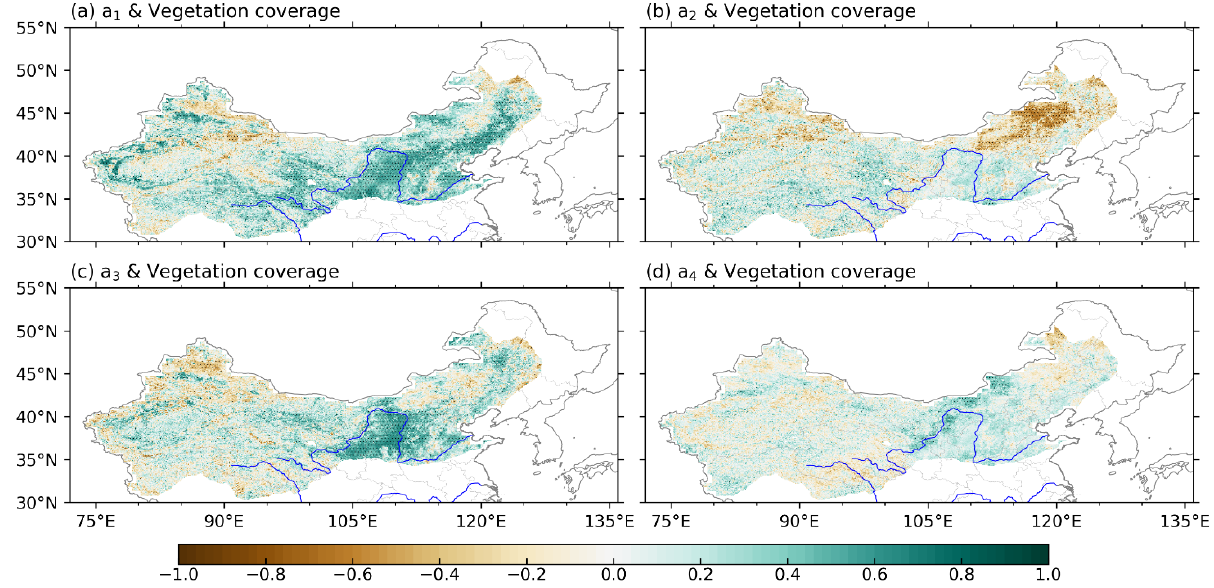
Figure 9. Pearson correlation coefficients at each grid point between the corresponding temporal coefficients of ETa for the four leading modes of the SVD analysis and NDVI in northern China during 1982–2017. The dots denote values exceeding the 95% confidence level.